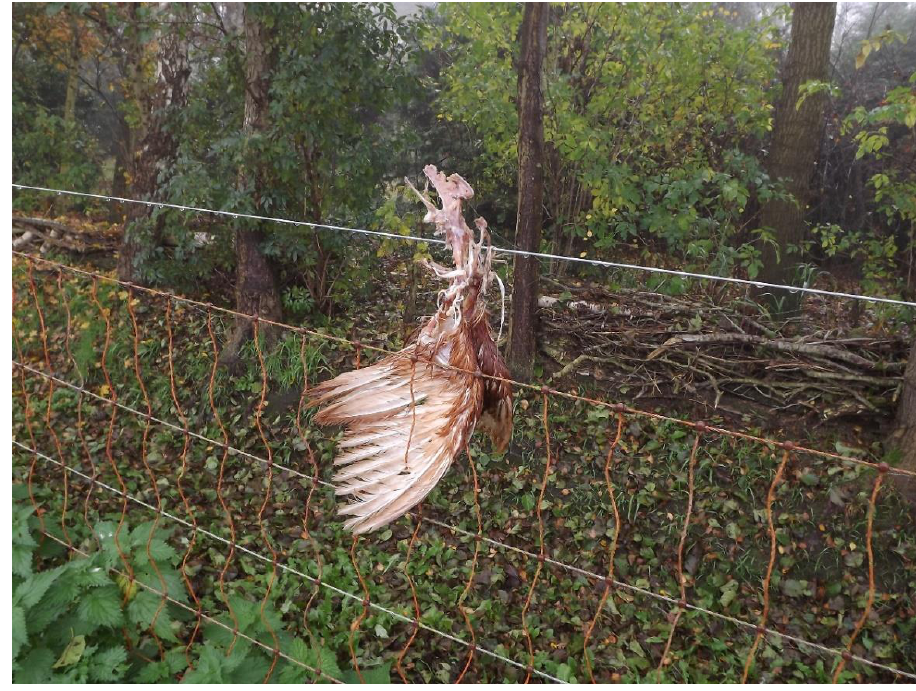
Figure 3. Chicken skeleton left on electric fence (farm 6).